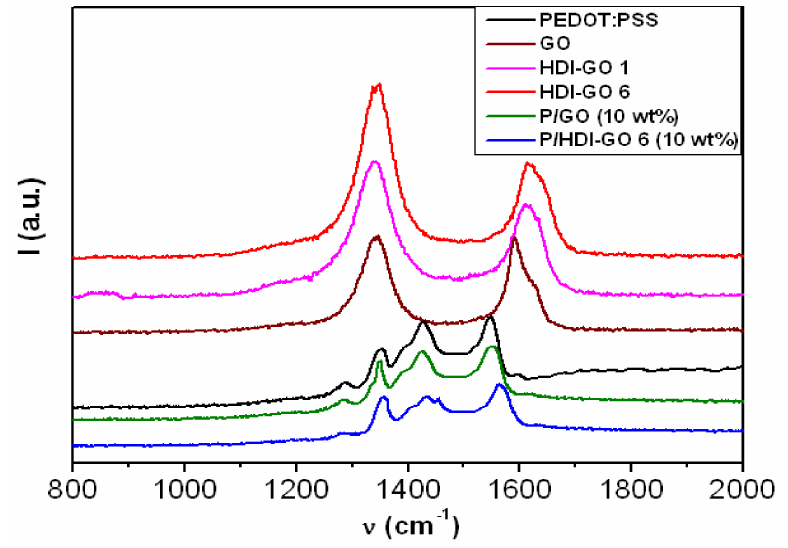
Figure 2. Raman spectra of neat PEDOT:PSS, raw GO, HDI-GO 1, HDI-GO 6, P/GO (10 wt %), and P/HDI-GO 6 (10 wt